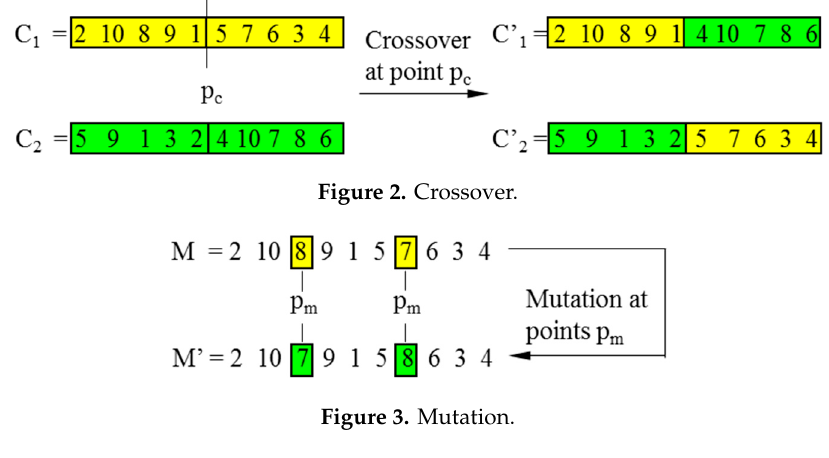
Figure 3. Mutation.